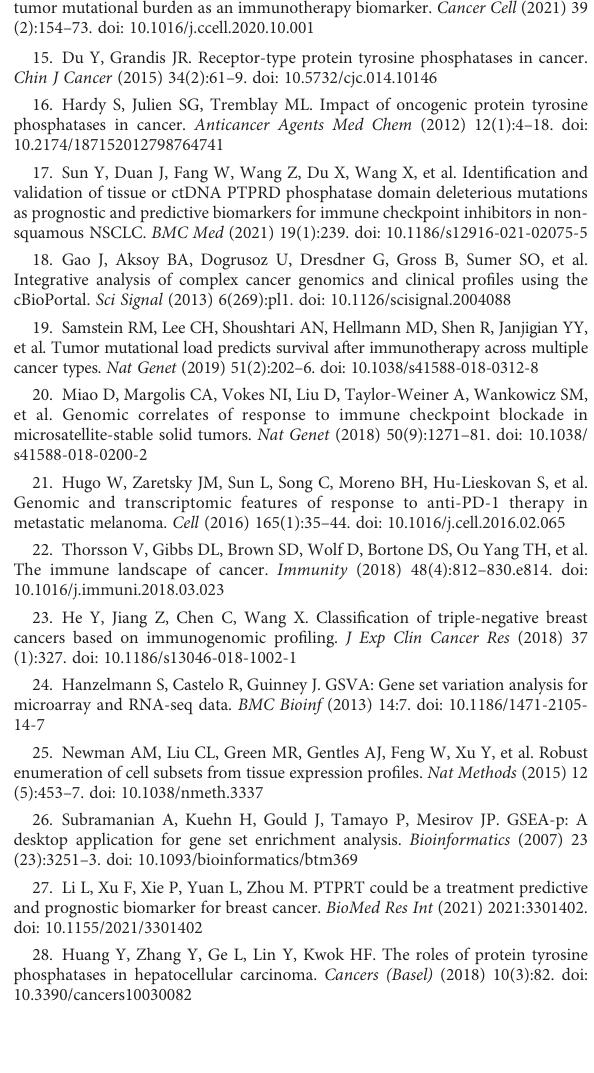
SUPPLEMENTARY FIGURE 3 Validation of the nomogram predicting OS in patients treated with ICIs. (A) ROC curves for predicting OS of the nomogram in the Miao et al. and Huguo et al. cohort. (B) Survival curve of OS with the nomogram according to the risk score in the Miao et al. and Huguo et al.